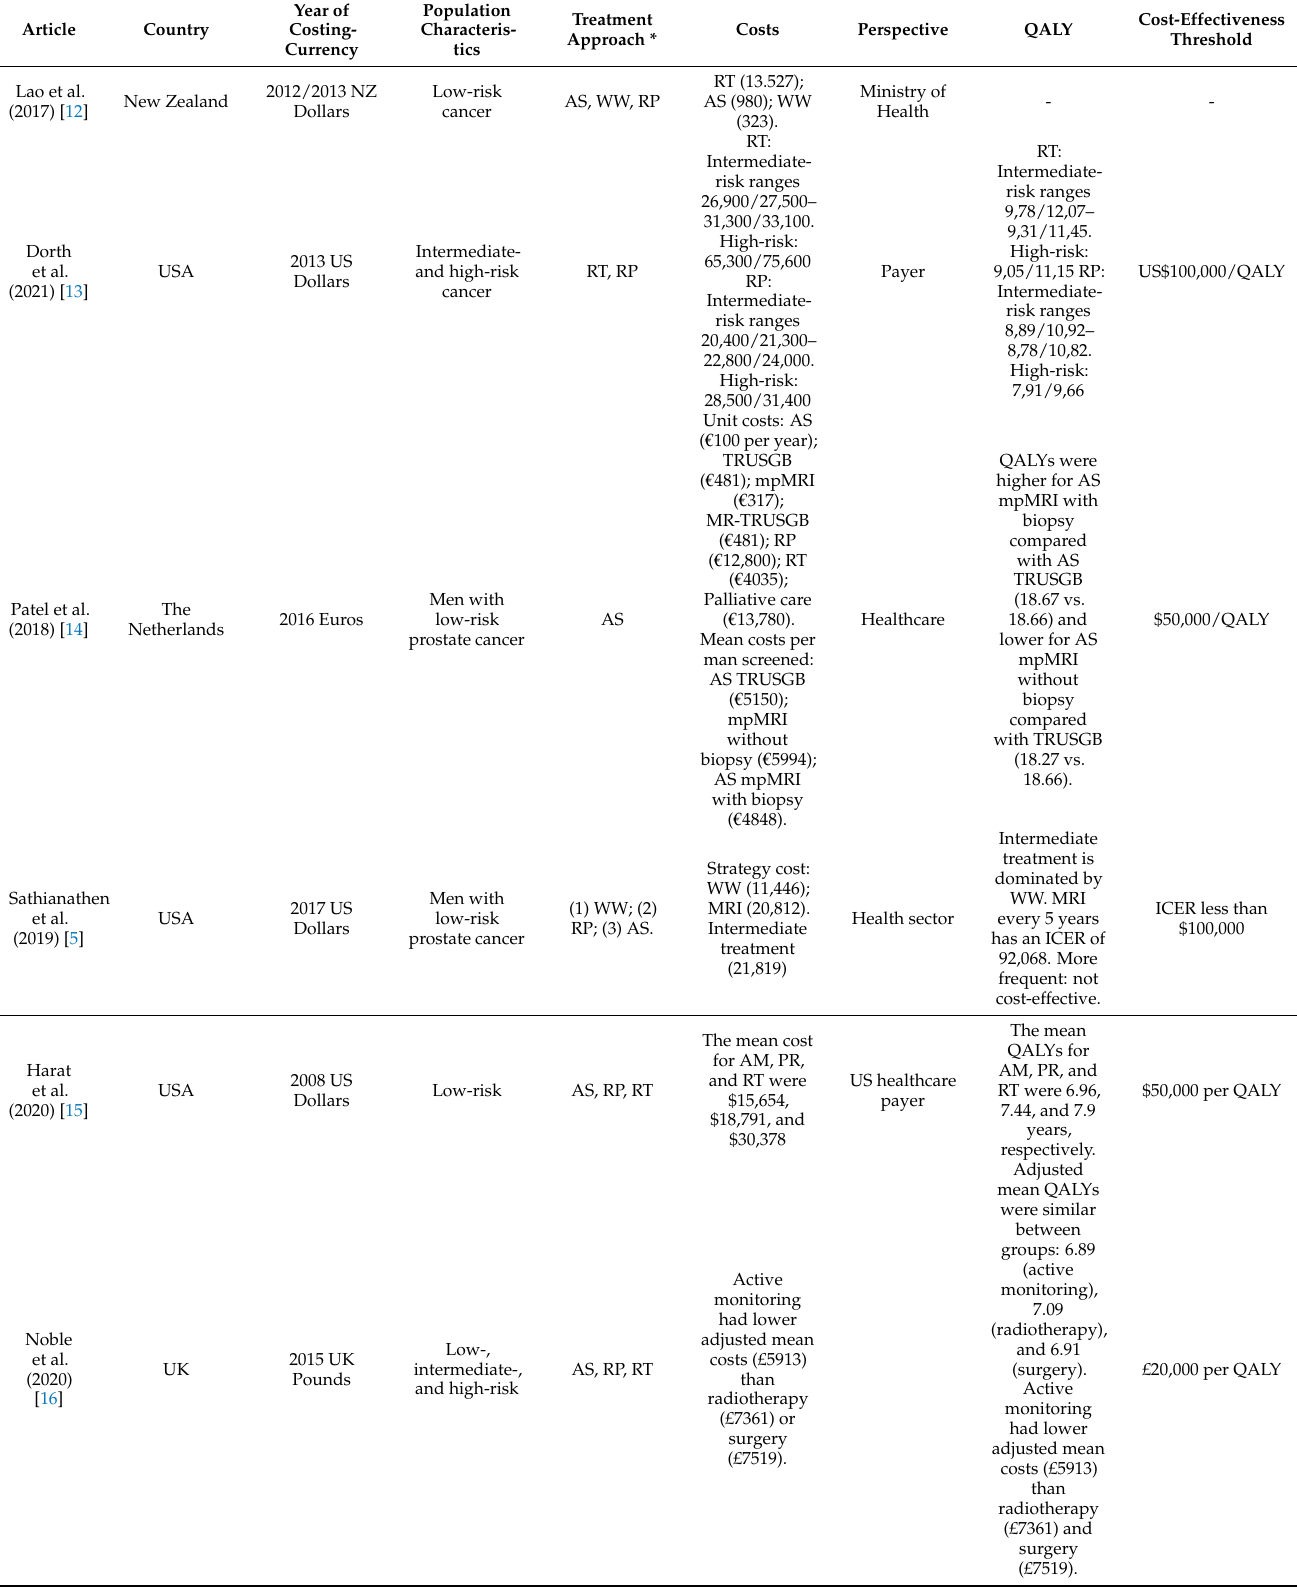
Table 2. Mapping of studies included in the analysis (N =